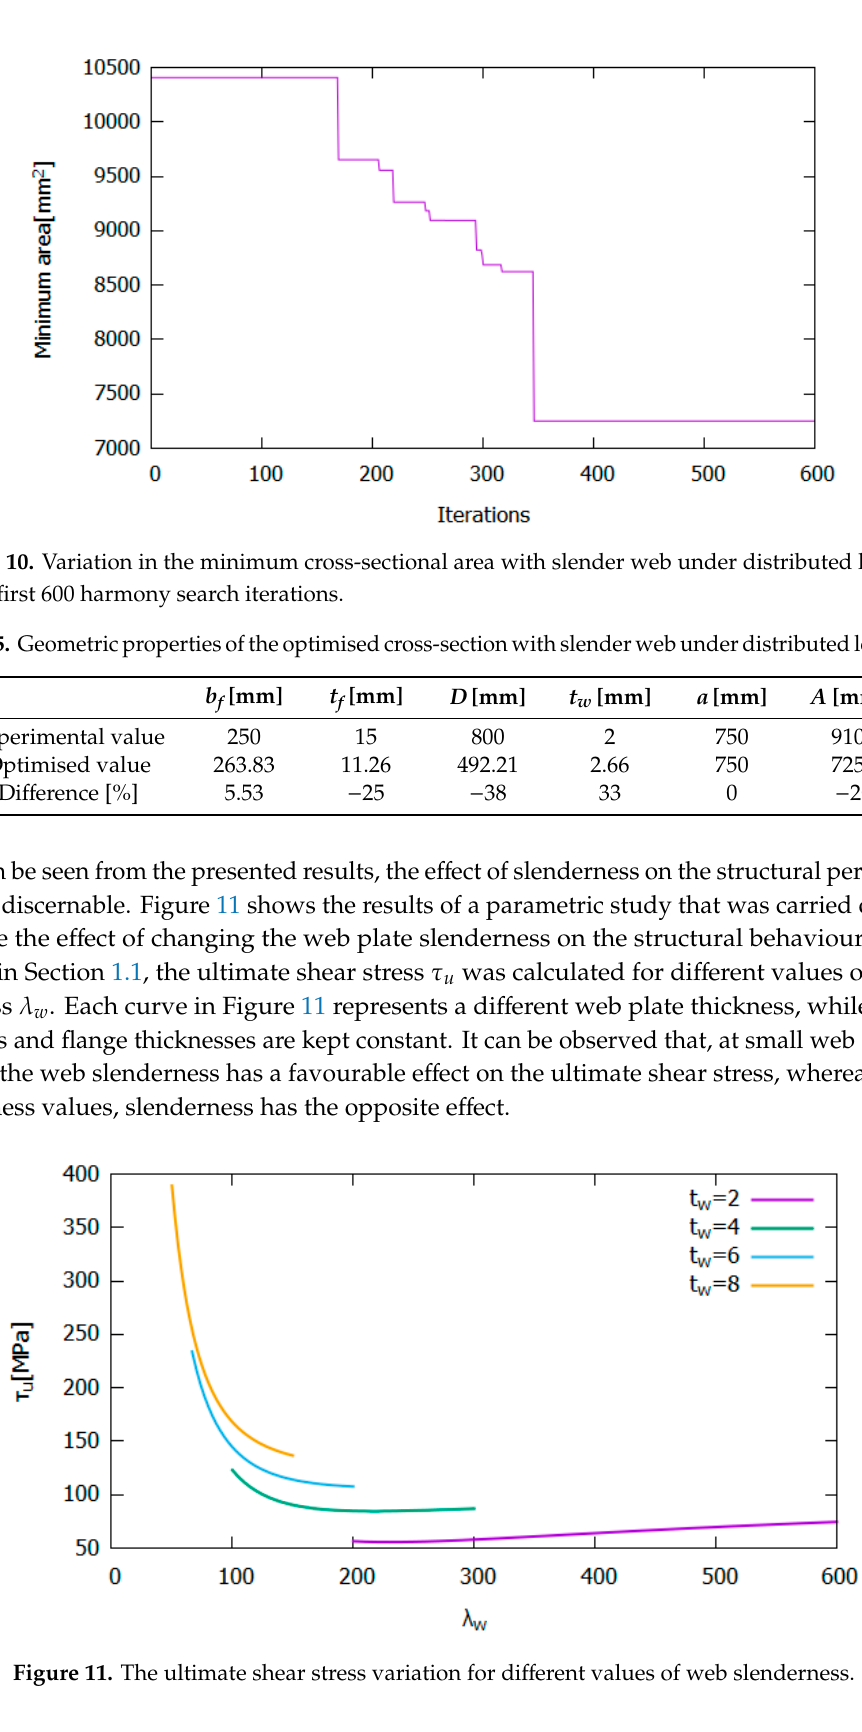
Figure 11. The ultimate shear stress variation for different values of web slenderness .